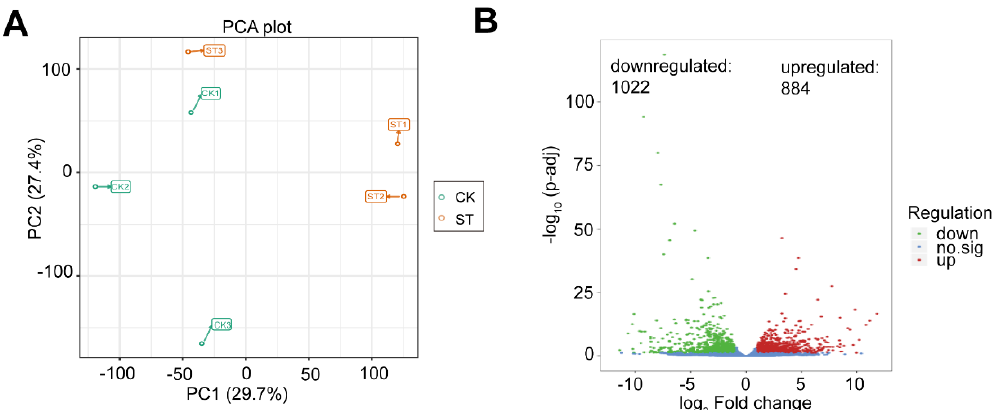
Figure 2. Low light treatment induced gene expression in the petiole of XH1 cai-tai seedlings. ( A ) Principal component analysis. ( B ) Volcano plot representing the differentially expressed genes induced by low light treatment.